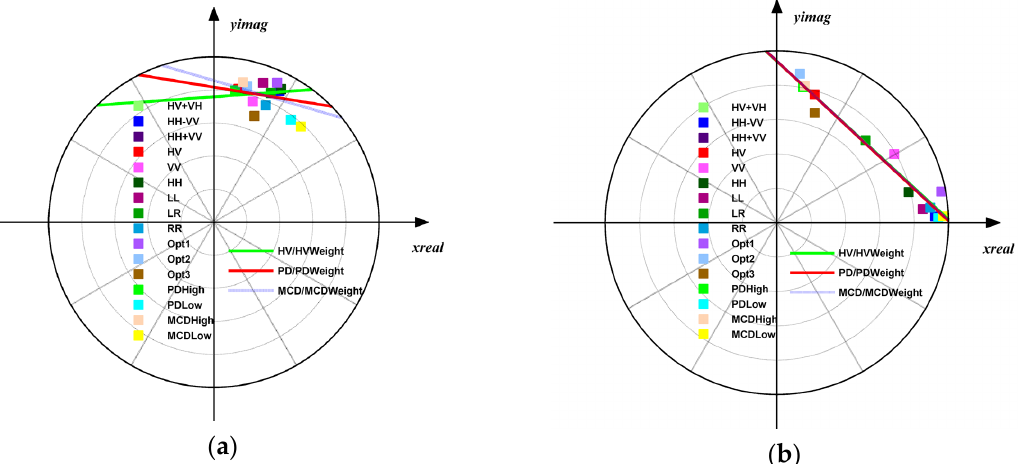
Figure 10. Comparison of complex coherence and fitted coherence straight lines in a complex plane. ( a ) azimuth = 70 range = 40; ( b ) azimuth = 51 range = 44.